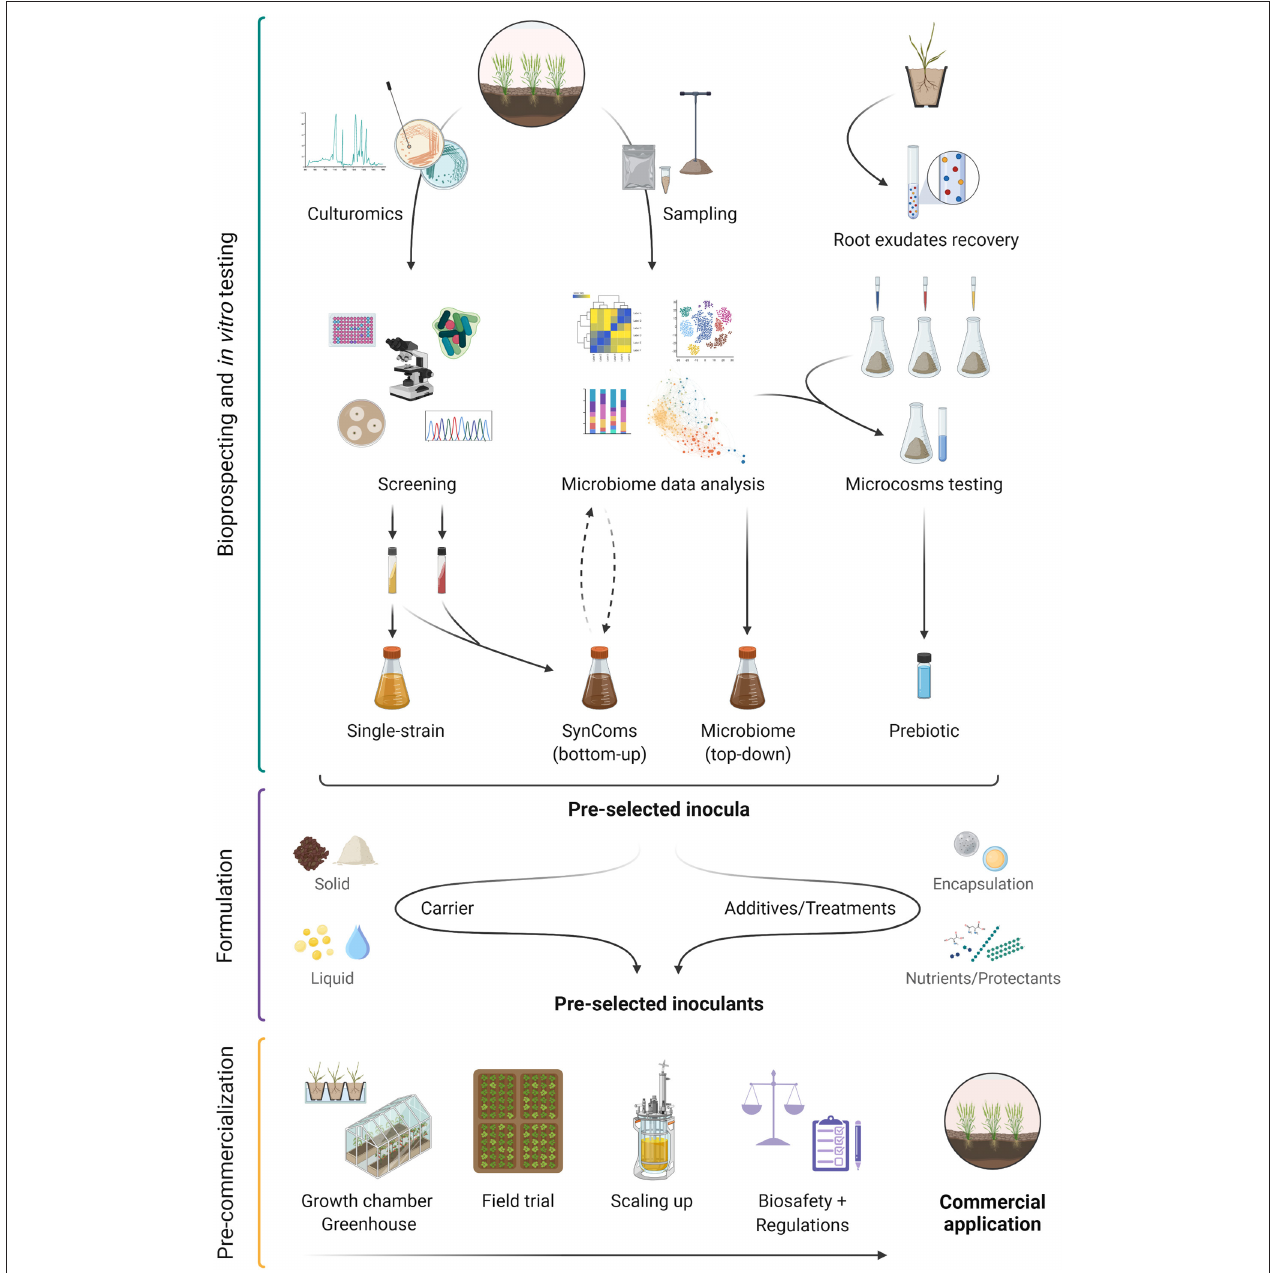
FIGURE 2 | Overview of biofertilizer development workflow from potential candidate microorganisms to commercial applications with four novel approaches: single-strain inoculant obtained using emerging culture-based methods (e.g., culturomics), synthetic microbial communities (SynComs) obtained from a bottom-up approach, whole microbiomes recovered from natural or engineered ecosystems (top-down approach), and prebiotics obtained from root exudates. Following the initial stages of bioprospecting and in vitro testing, selected inocula and/or prebiotics require a proper formulation to ensure shelf life and protection. Finally, product pre-commercialization steps include in planta trials under controlled (growth chamber/greenhouse) and uncontrolled (field) conditions, production scale-up to a commercial scale, proper biosafety screening tests (e.g., toxicity and pathogenicity), and compliance with existing regulations. Created with BioRender (https://